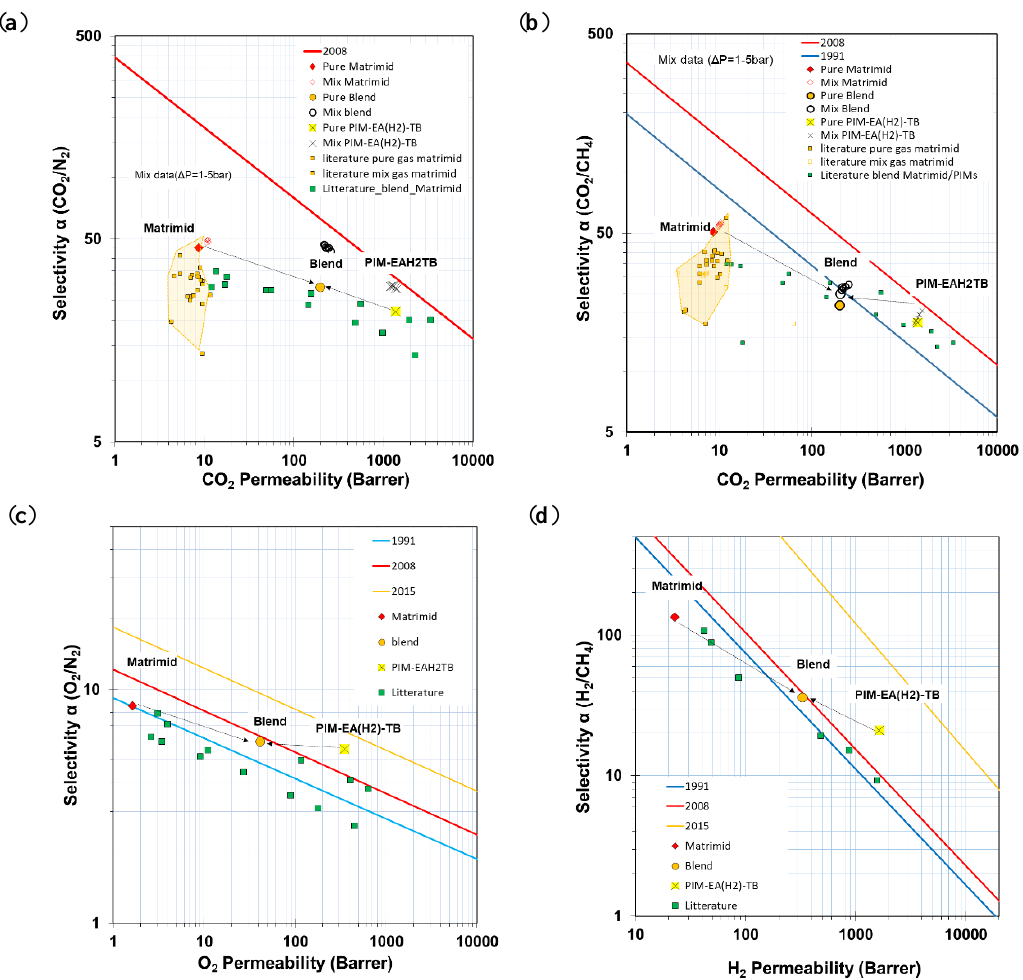
Figure 5. Robeson’s plots of ♦ neat Matrimid ® 5218, X PIM-EA(H 2 )-TB and Matrimid ® 5218/PIM blend membranes for CO 2 /N 2 ( a ), CO 2 /CH 4 ( b ), O 2 /N 2 ( c ) and H 2 /CH 4 ( d ) gas pairs (pure gas filled symbols and Mixed gas open symbols). Reference data for other matrimid-based blends ( ■ ) and other PIM-based blends ( ■ ) are plotted for comparison.